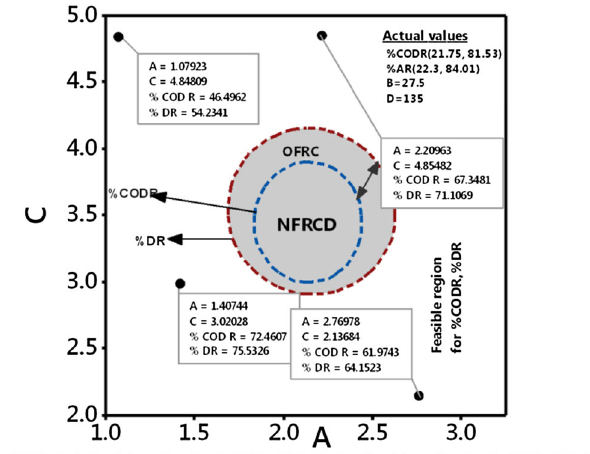
Fig. 7 Contour overlay